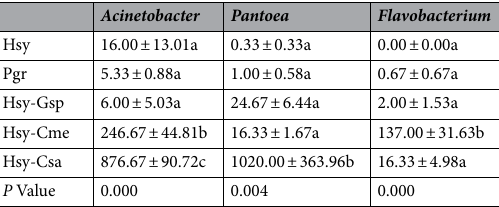
Table 3. Abundance of 3 symbiotic bacteria in insects (mean ± SE) among Hsy, Pgr, Hsy-Gsp, Hsy-Cme and Hsy-Csa. Different lowercase letters within a row represent significant differences among treatments (P < 0.05).